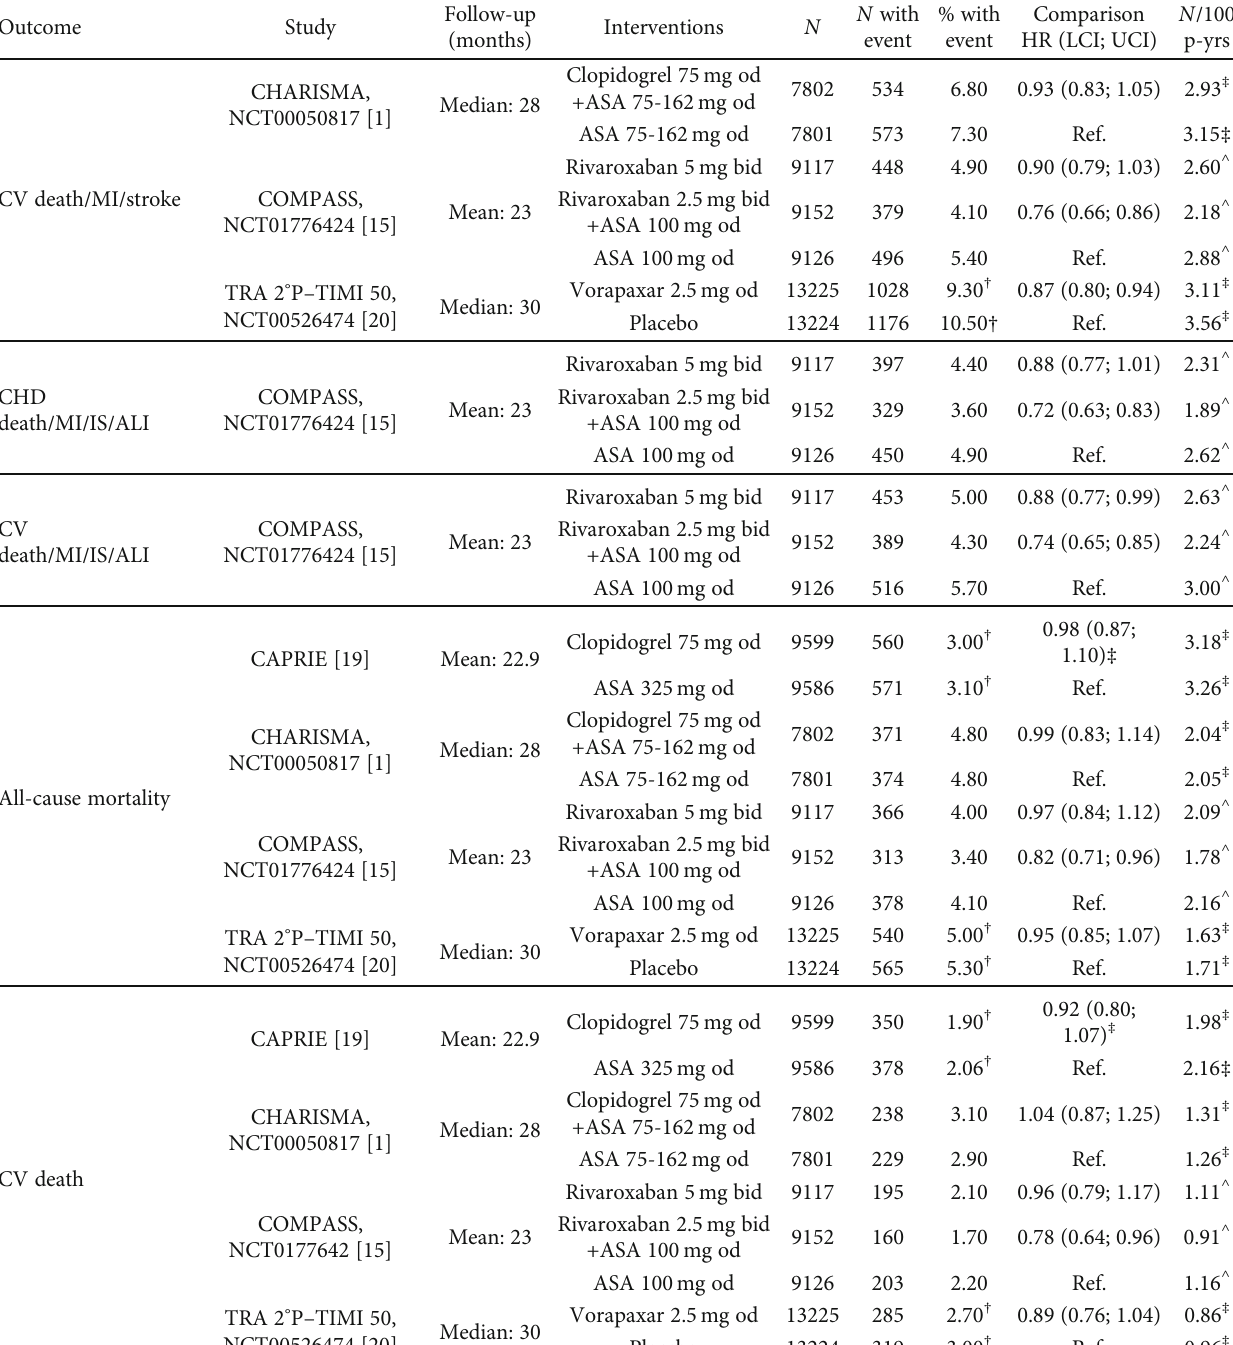
Table 3: Key e ffi cacy and safety